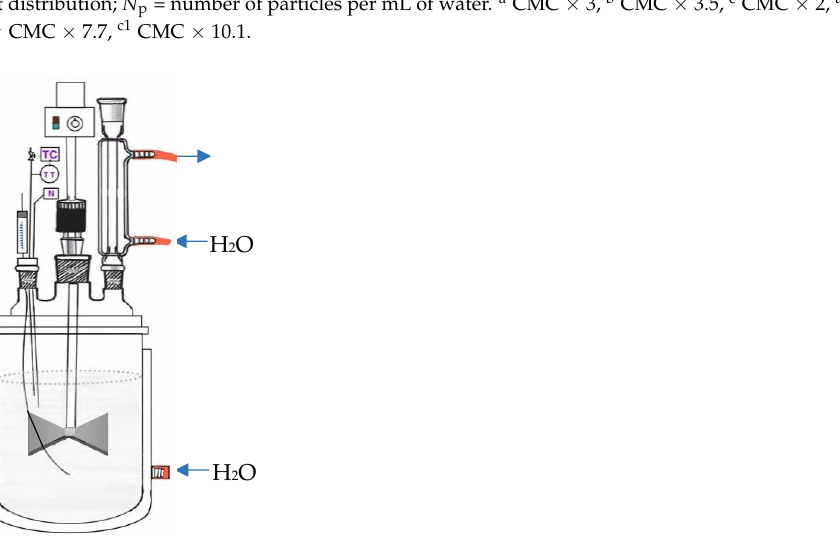
Figure 2 . Schematic representation of the EP reactor. Figure 2. Schematic representation of the EP